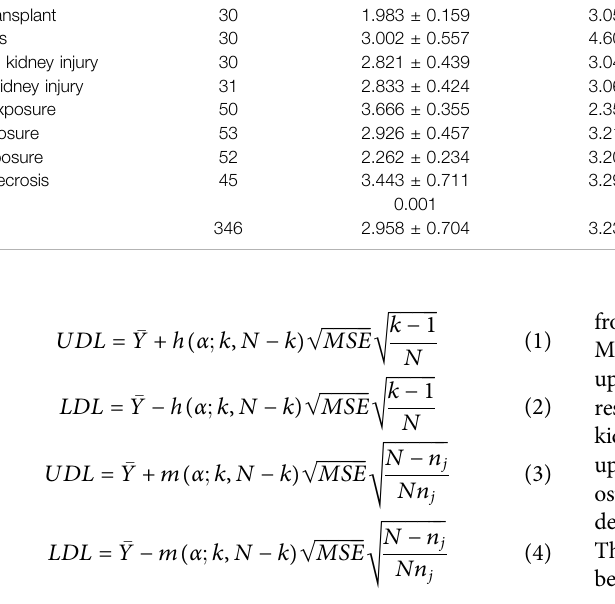
CAT (U/L) Mean ± Std. Dev